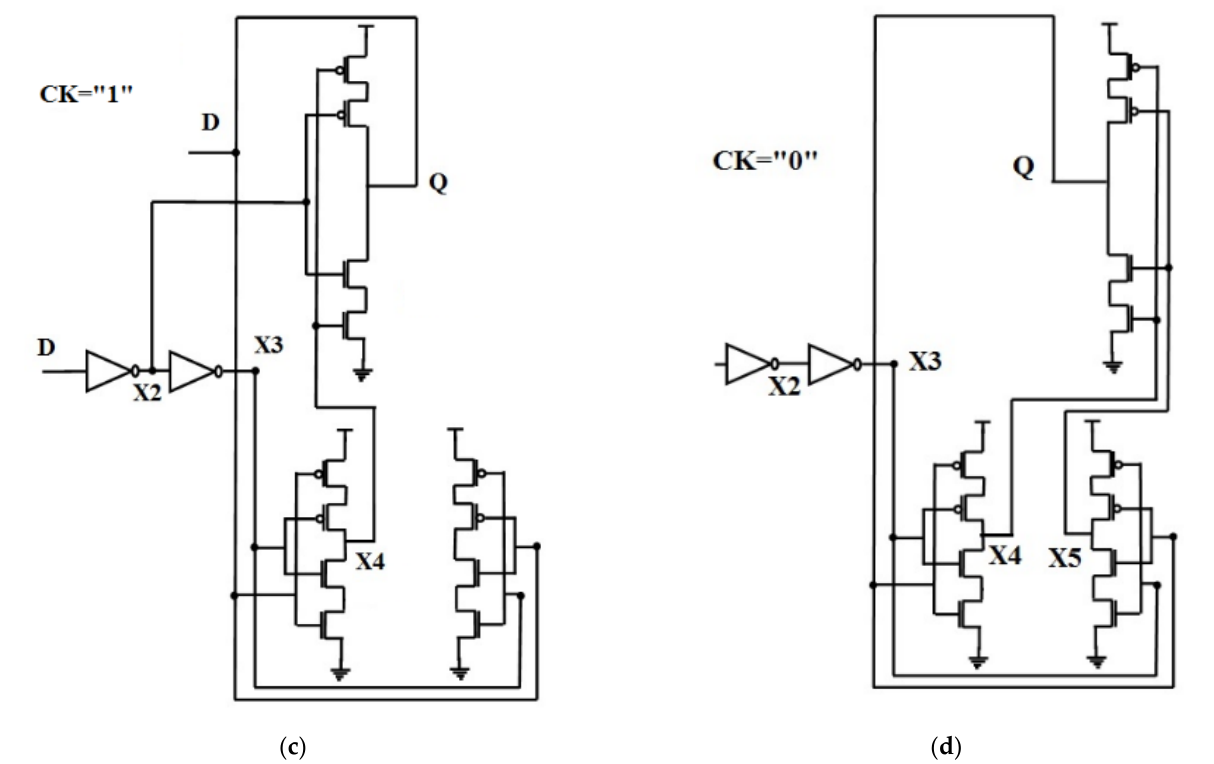
Figure 2. Proposed D-latch ( a ) schematic ( b ) layout ( c ) Equivalent schematic when CK = ”1”, ( d ) Equivalent schematic when CK = ”0”.